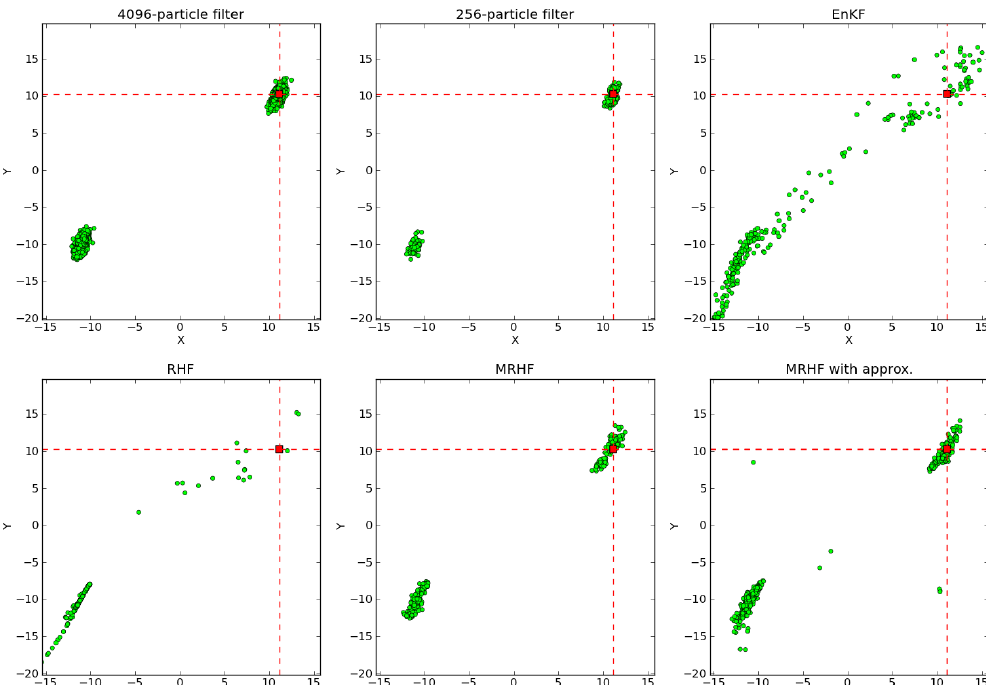
Figure 12. Scatter plots of the analysis ensembles with 256 particles (except upper-left) at the 389th analysis cycle, in the X – Y plane of Lorenz 63 model phase space: 4096-SIR particle filter (considered as the reference solution) (upper left panel); Particle filter (upper center panel); EnKF (upper right panel); RHF (bottom left panel); MRHF (bottom center panel); Mean-field approximation MRHF (bottom right panel). The red dashed lines indicate the truth from which the observation of Z is